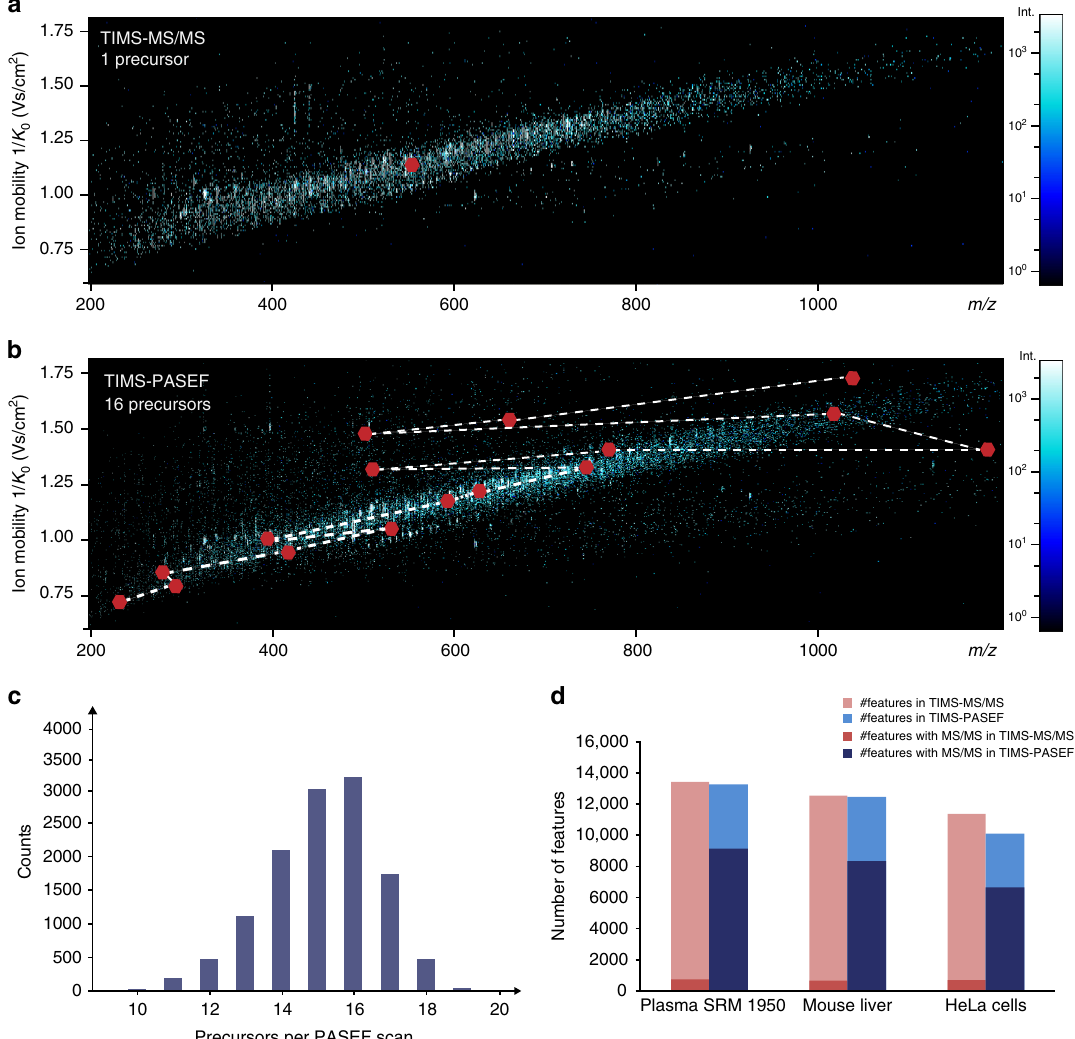
Fig. 2 Evaluating PASEF in lipidomics. Heat-map visualization of a representative trapped ion mobility resolved mass spectrum of human plasma at an elution time of 9.2 min. Red dots indicate precursors selected for MS/MS fragmentation in the subsequent 100 ms PASEF scan in a , standard TIMS-MS/ MS mode and b TIMS-PASEF mode. The dashed line indicates the positioning of the quadrupole. c Distribution of the number of precursors per PASEF scan in an LC-MS analysis of human plasma lipid extract ( n = 1). d Total number of 4D features extracted from 30 min runs of human plasma ( n = 5), mouse liver ( n = 5), and human cancer cells ( n = 5) in positive ion mode without (TIMS-MS/MS, red) and with PASEF (TIMS-PASEF, blue). The fraction of features with assigned MS/MS spectra is indicated by a darker